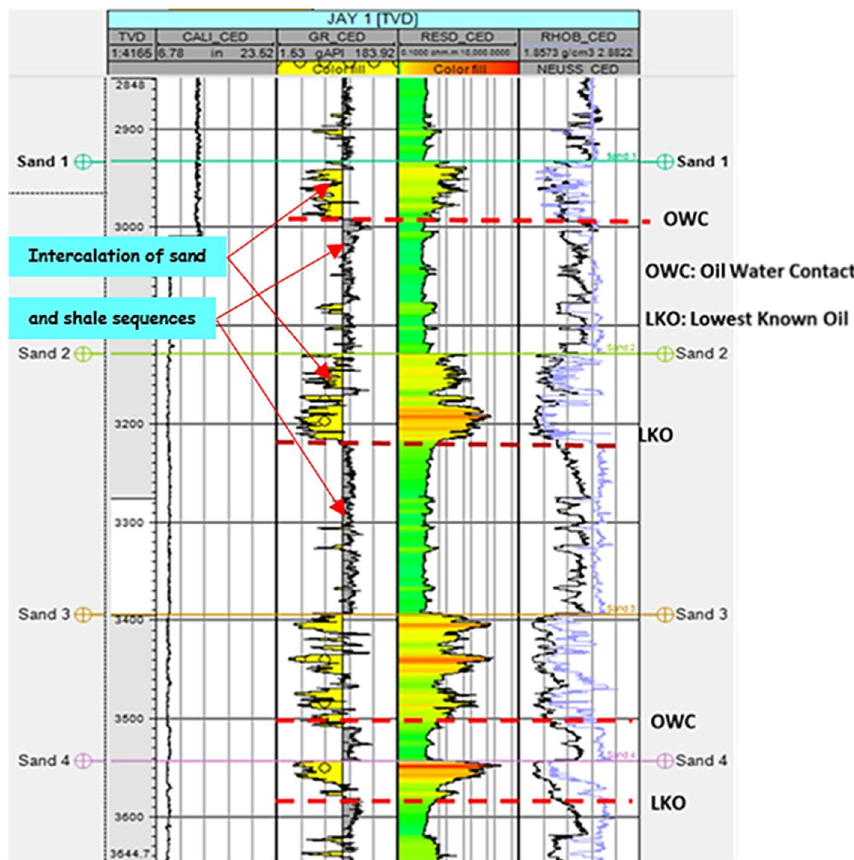
Fig. 5 Identified lithologies and hydrocarbon contact on well Jay 1